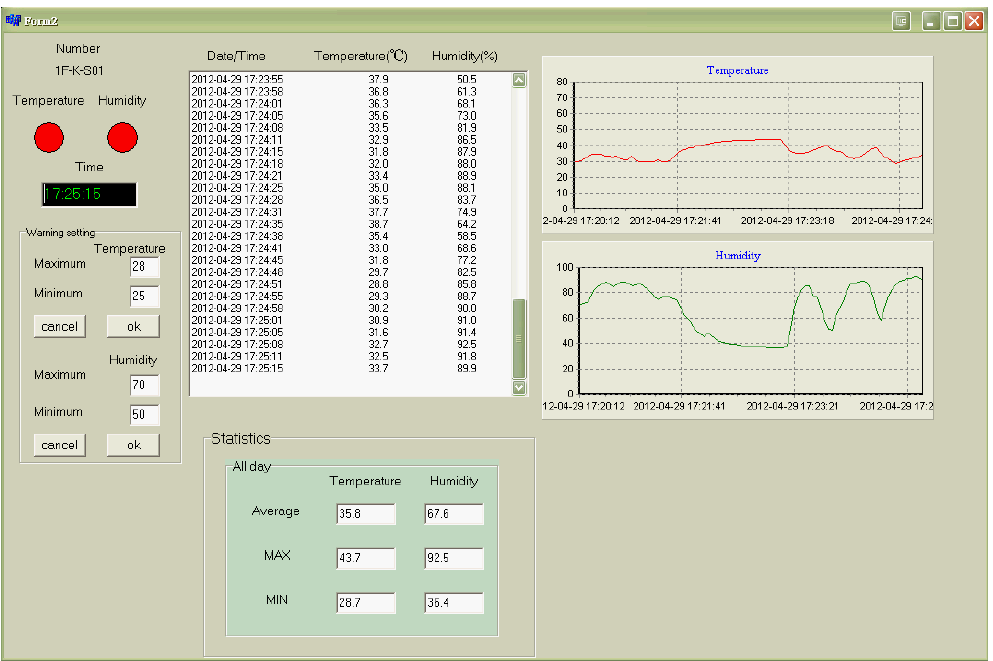
Figure 5. Display of point